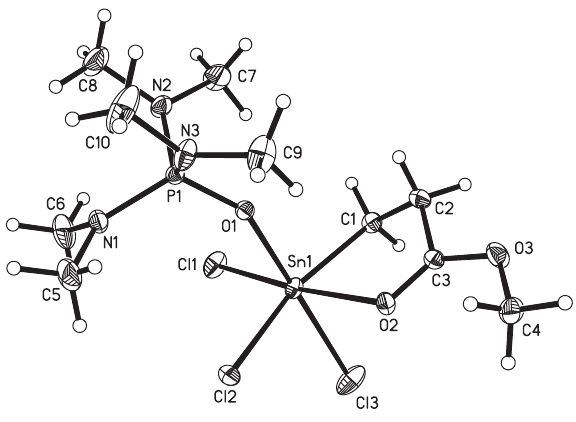
Figure 1: The molecular structure of 1 . Anisotropic ellipsoids are represented at a 30% probability